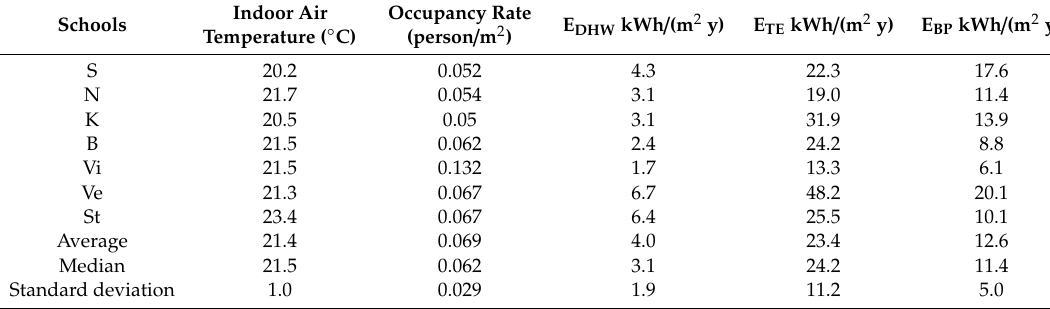
Table 2. Measured user-related parameters in seven low-energy schools. Average, median, standard deviation, minimum and maximum values were calculated from the measured values. The indoor air temperatures were averages measured during the heating season. E DHW is given in terms of thermal energy. The area m² in the table refers to floor area heated to 10 °C or above (A temp ).